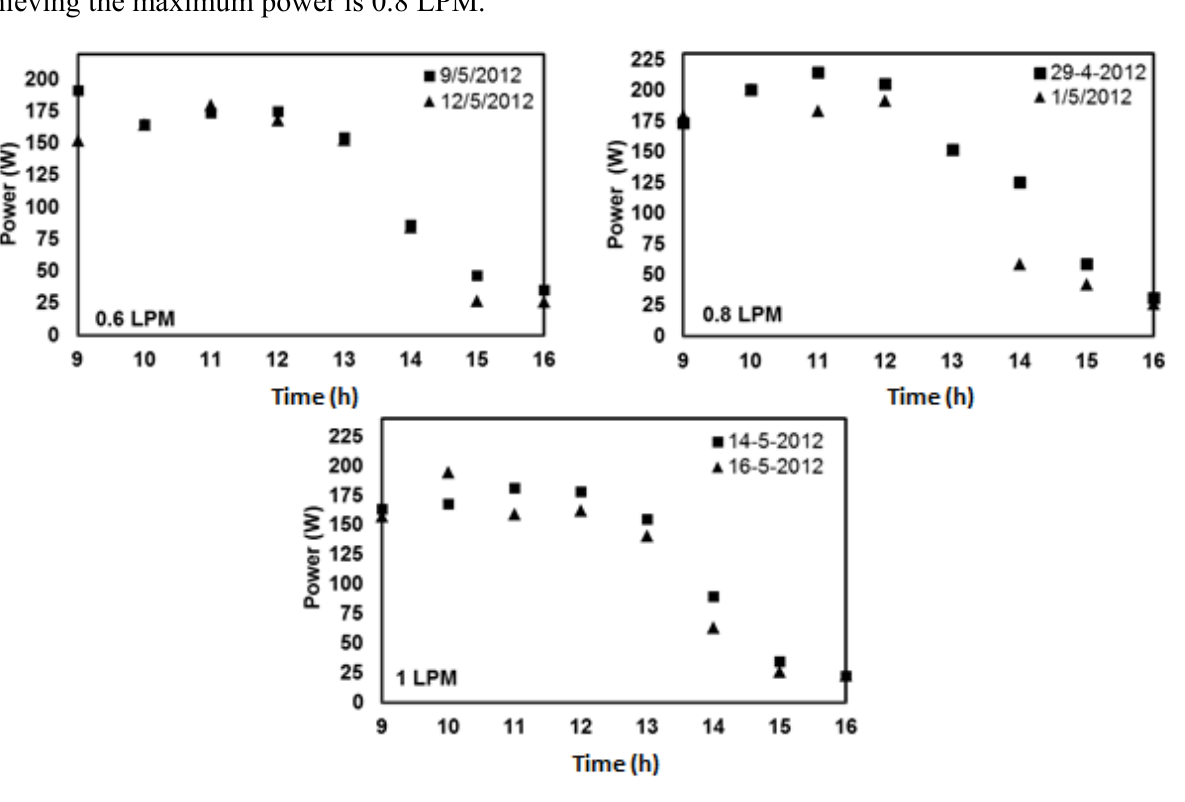
Figure 19. Power output from V-trough PV